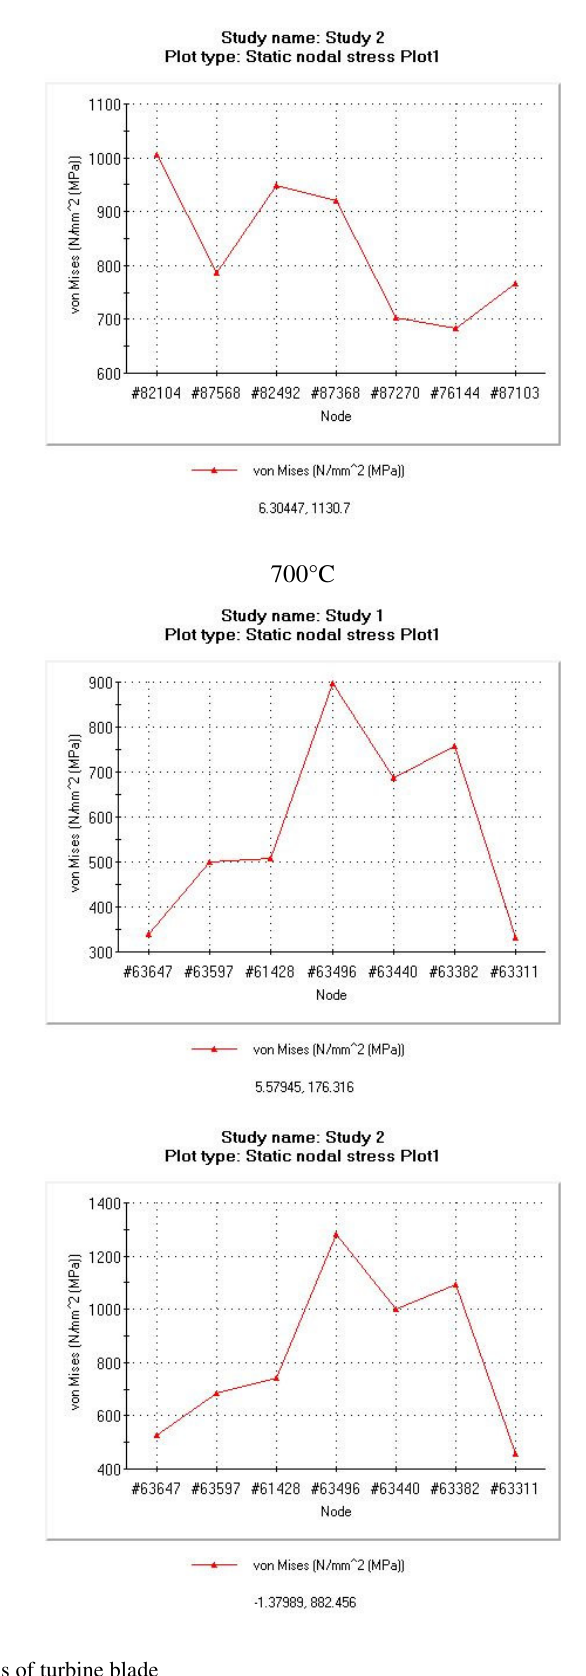
Fig 4. Stress analysis of turbine